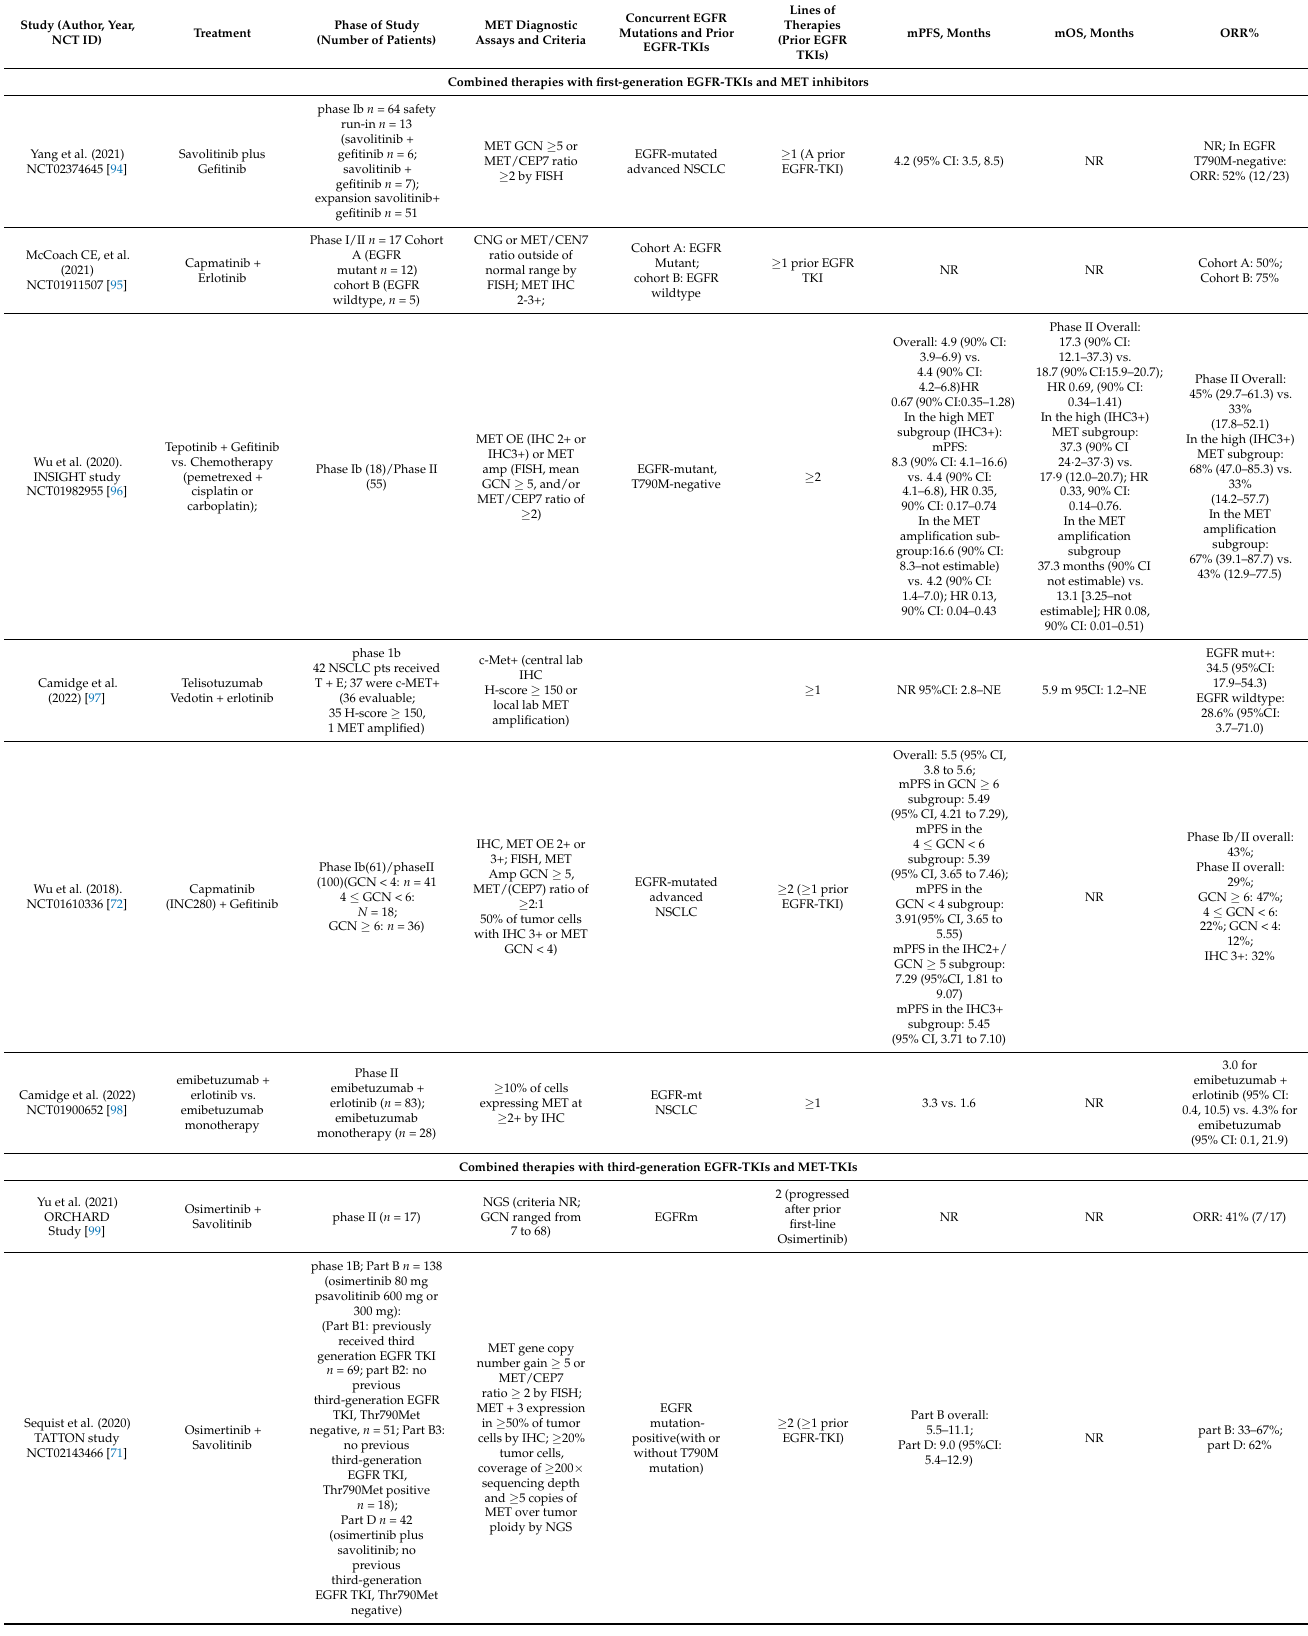
Table 1. Summary of key clinical studies on combined therapies to overcome acquired MET- amplification-mediated resistance to EGFR-TKIs in EGFR-mutated